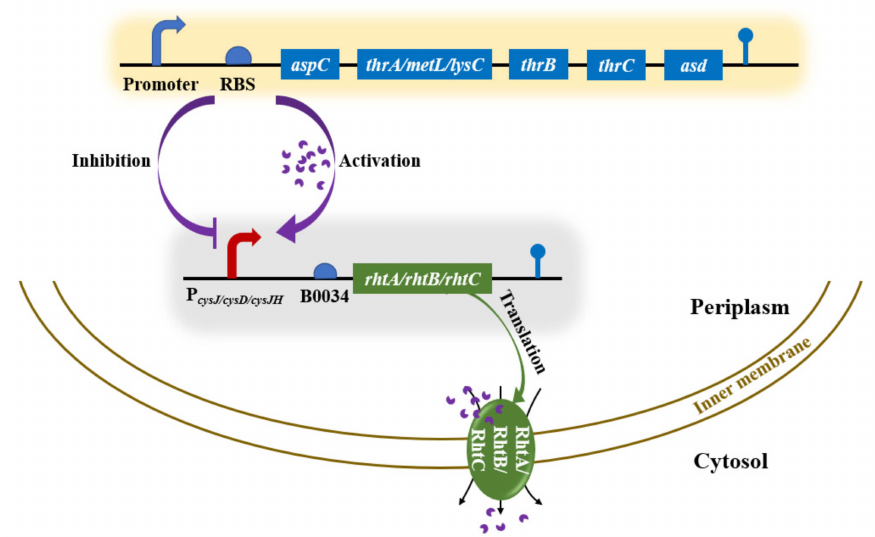
Figure 1. Scheme of sensing L-threonine to regulate transporter expression. The L-threonine produc- tion pathway consists of five genes: aspartate aminotransferase encoded by aspC ; aspartate kinases encoded by thrA , metL , or lysC ; semialdehyde dehydrogenase encoded by asd ; homoserine dehydroge- nase encoded by thrA ; homoserine kinase encoded by thrB ; and threonine synthase encoded by thrC . Three transporters were encoded by rhtA , rhtB, and rhtC . L-threonine transporters belong to the inner membrane. P cysJ , P cysD , and P cysJH are L-threonine-sensed promoters for activating gene